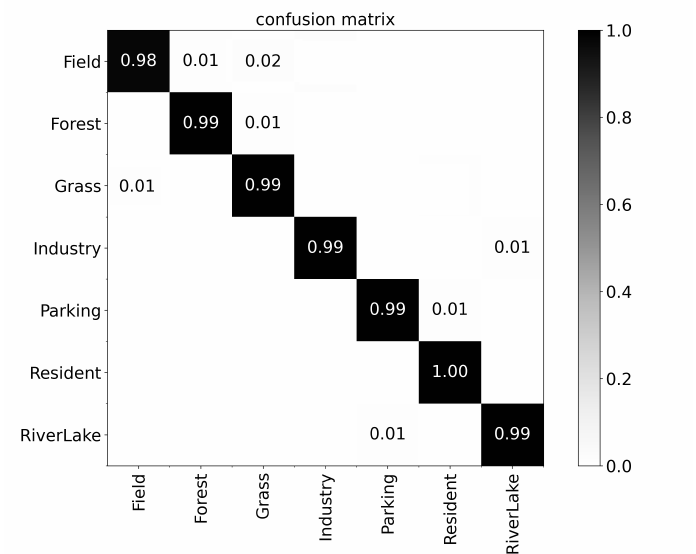
Figure 14. Confusion matrix of our model on RSSCN dataset.